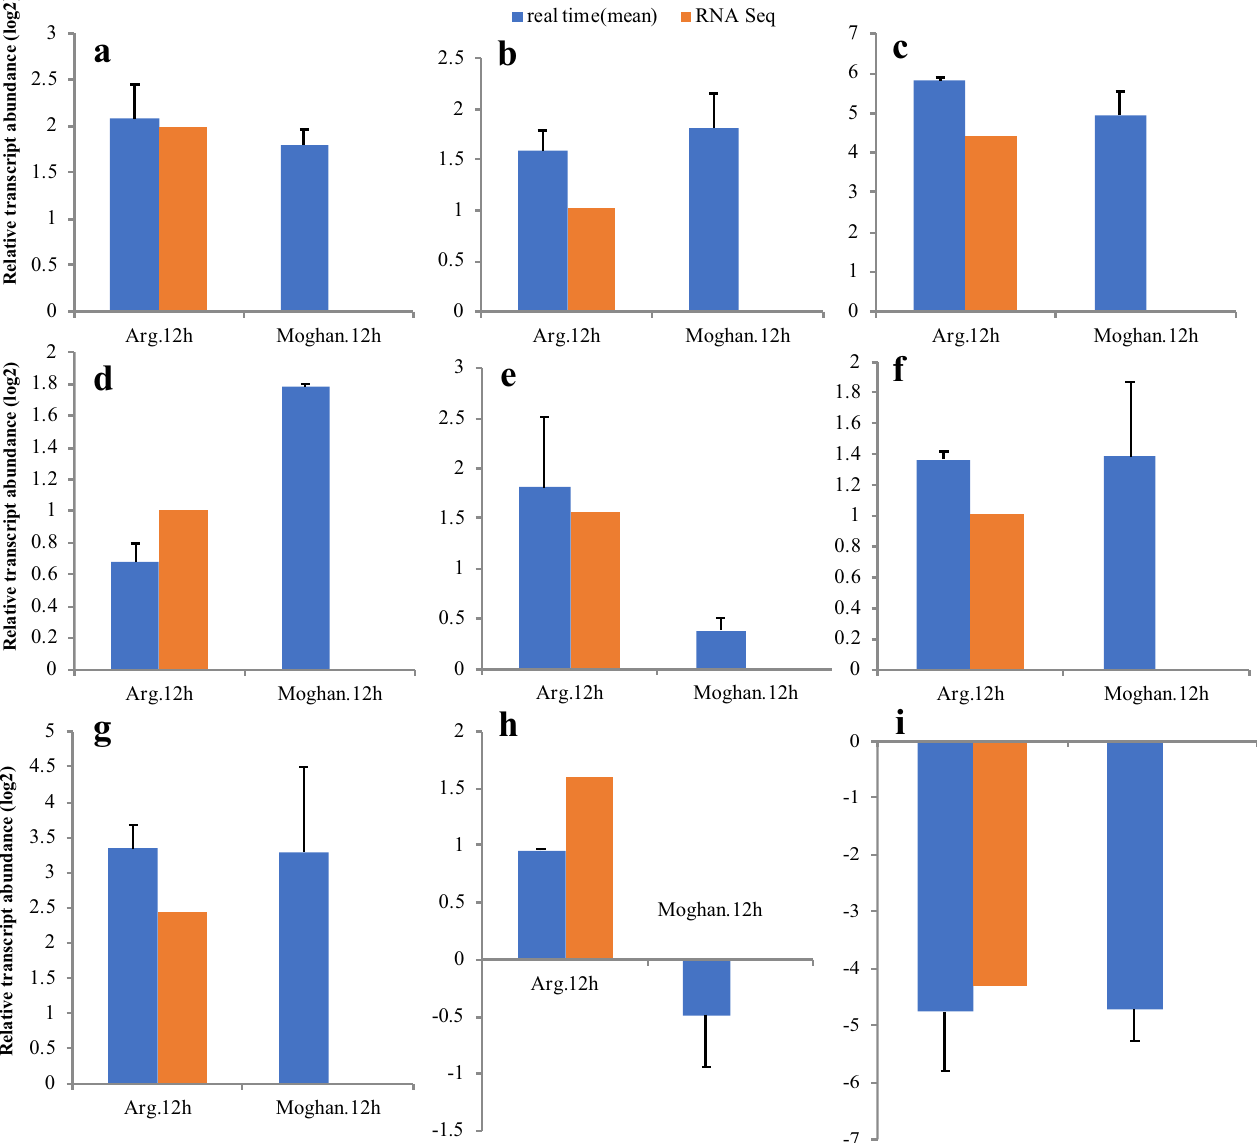
Fig 6. Validation of selected genes using qRT-PCR. (a) Calcineurin B-like protein (CBL)-CBL-interacting protein kinase 31 ( Ta . CIPK31 );(b) NAC transcription factor 15 ( Ta . NAC15 ); (c) Heat Shock transcription factor C1b ( Ta . HsfC1b );(d) Salt Overly Sensitive 1 ( Ta . SOS1 ); (e) Dehydration-responsive protein RD22 ( Ta . RD22 ) (f) bHLH transcription factor ( Ta . bHLH ); (g) late embryogenesis abundant protein 3 ( Ta . LEA3 ); (h) salt tolerant-related protein ( Ta . STRP ); (i) Proline oxidase ( Ta . POX ). The gene ensemble Ids are mentioned in the S1